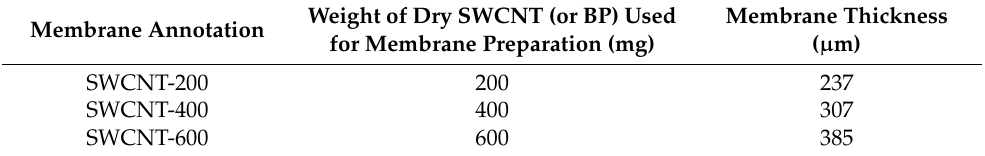
Table 1. Prepared SWCNT membranes.